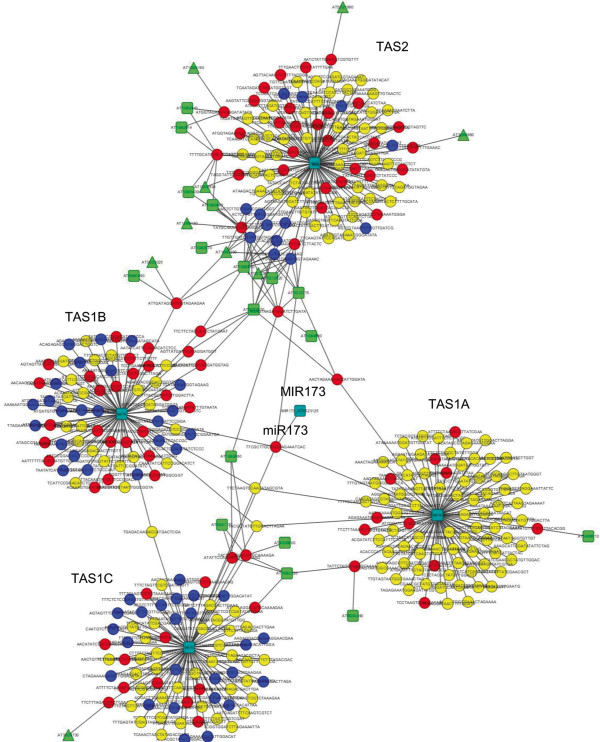
The miR173-tasiRNAs-PPR/TPR network is significantly altered in the OE lines. Circles are 21-nt small RNAs that are perfectly mapped to TAS loci; red circles: Increase in small RNAs abundance in both OE lines (ratio ≥ 2, P < 0.05); blue circles: Decrease in small RNAs abundance in both OE lines (0 < ratio ≤ 1/2, P < 0.05); yellow circles: small RNAs which are not significantly changed in the OE lines. Green squares: potential PPR targets. Green triangles: potential TPR targets. Dark green squares: TAS1A, 1B, 1C, TAS2 and MIR 173 genes.